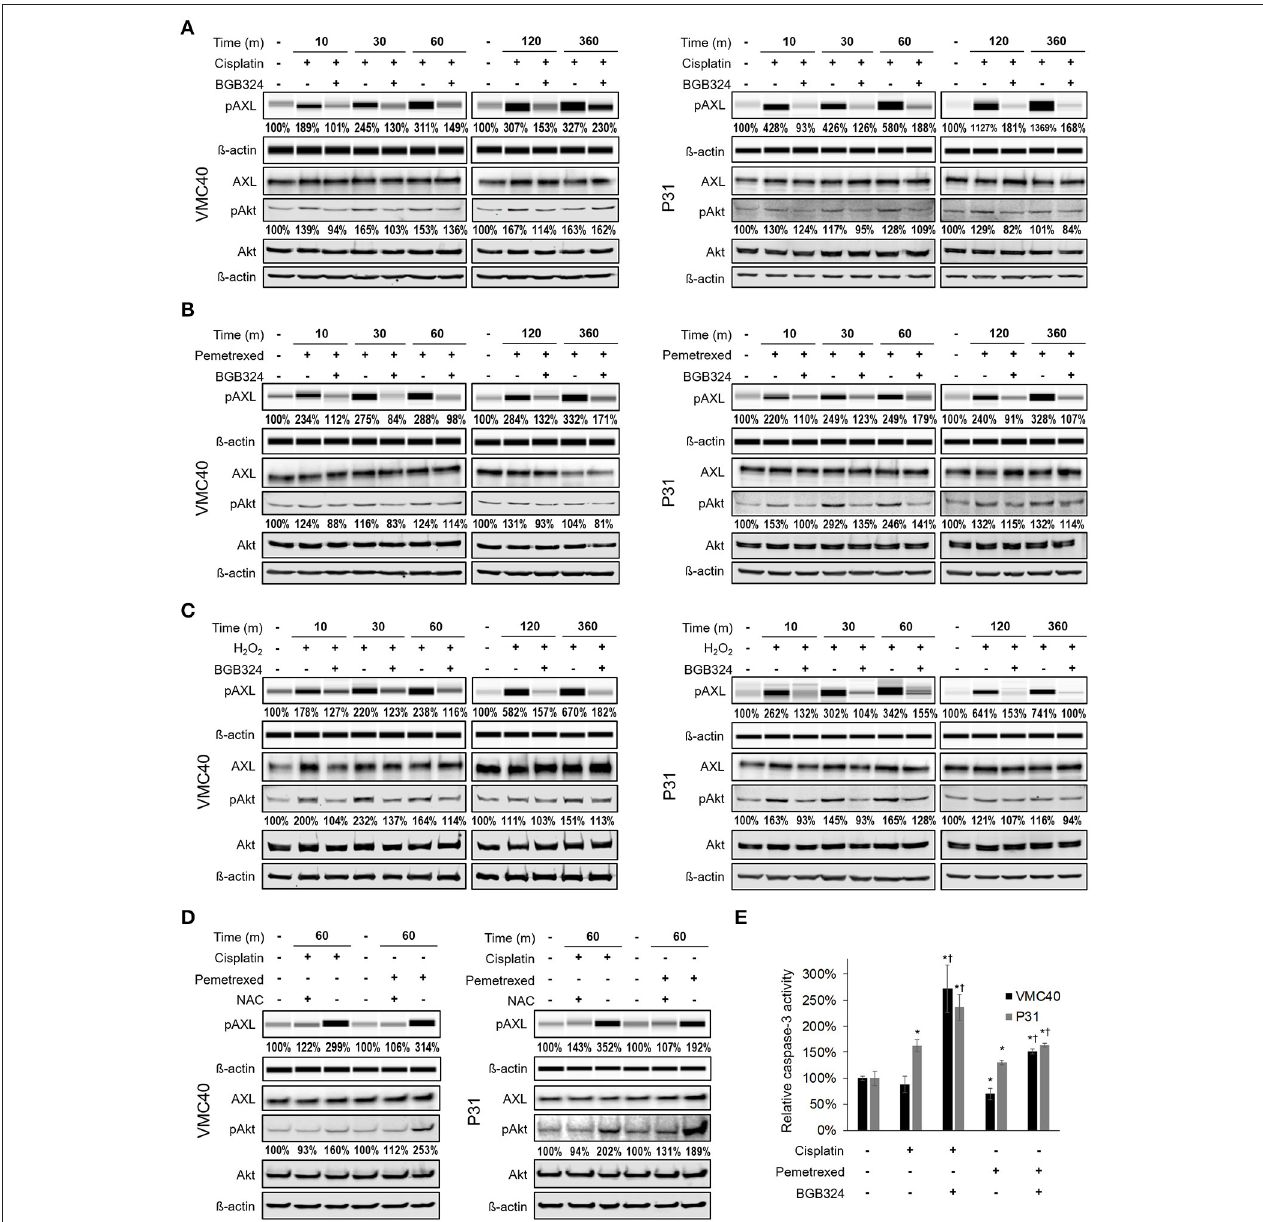
FIGURE 3 | Cisplatin and pemetrexed promote phosphorylation of AXL and downstream Akt. (A–C) Time course of pAXL and downstream pAkt detection in the presence of (A) 15 µ M cisplatin, (B) 8 µ M pemetrexed, and (C) 150 µ M H 2 O 2 . Phosphorylation of AXL was inhibited by adding 2 µ M BGB324. Densitometry values as percentage of untreated control are shown for pAXL and pAkt, normalized to respective beta-actin. (D) pAXL detection with the addition of 4mM N-acetylcysteine (NAC) antioxidant at 60m. Lysates (A–D) were analyzed for pAXL using capillary electrophoresis, and other proteins were detected by standard immunoblot methods. Densitometry values are relative to corresponding protein of untreated control, normalized to respective ß-actin loading control. (E) Caspase 3 activity after 24h of indicated drug treatment. Error bars represent ± SEM of three experiments. * and † denote p < 0.05 via t -test for value compared to untreated control and to drug combination,